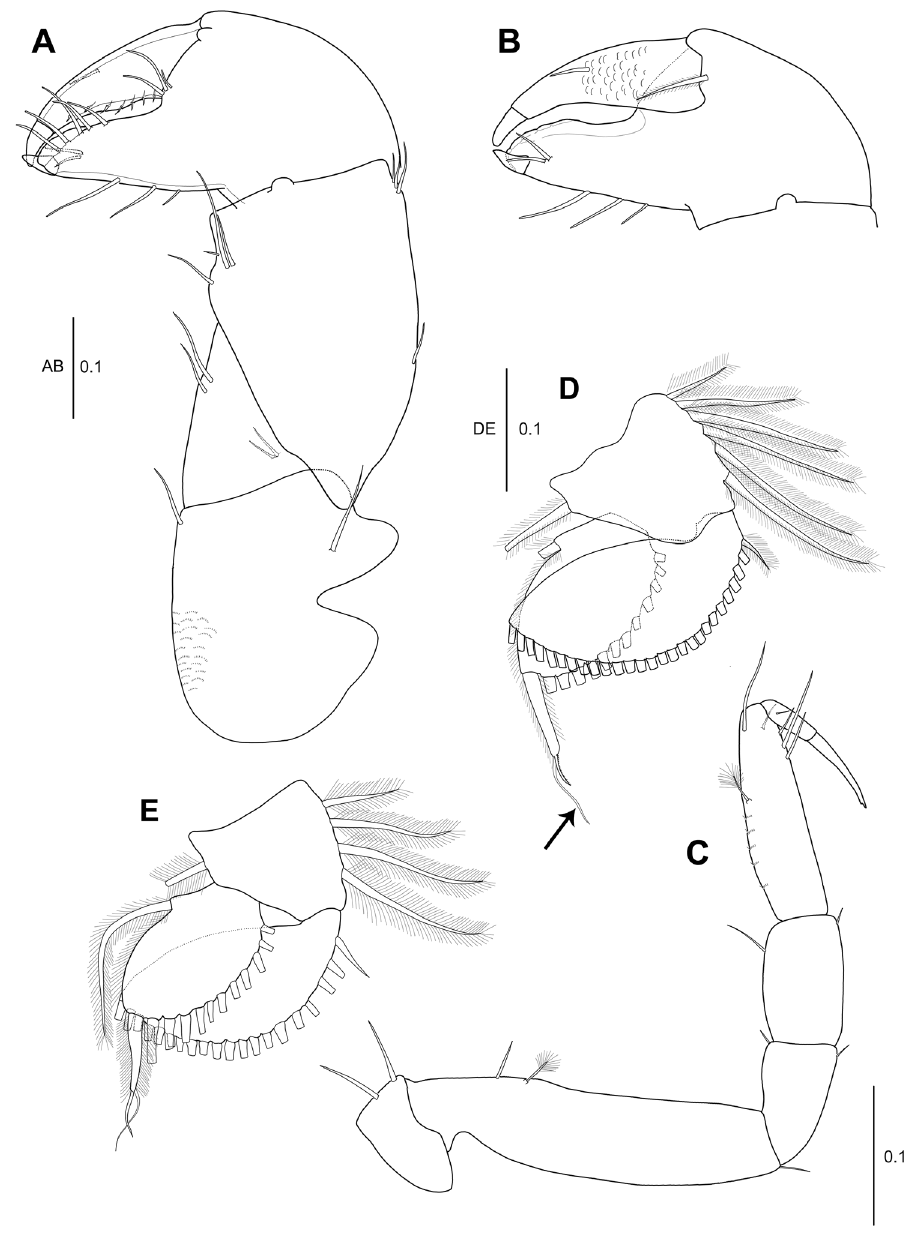
Figure 9. Hexapleomera ulsana sp. n., Jeju population, female, A cheliped B cheliped chela, inner surface C pereopod 1 D pleopod 1 E pleopod 3. Scale bars in